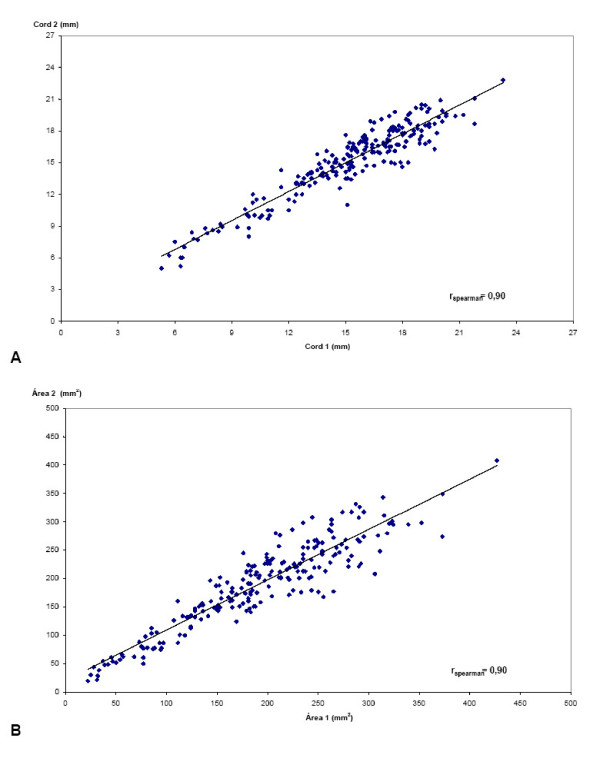
Linear correlation (r = correlation coefficient of Spearman) of the inter-observer ultra-sonographic measurements: A. of the diameter of the umbilical cord (cord1 and cord2 are respectively the measurements of observer 1 and 2); and B. of the cross-sectional area of the umbilical cord (area1 and area2 are respectively the measurements of observer 1 and 2).